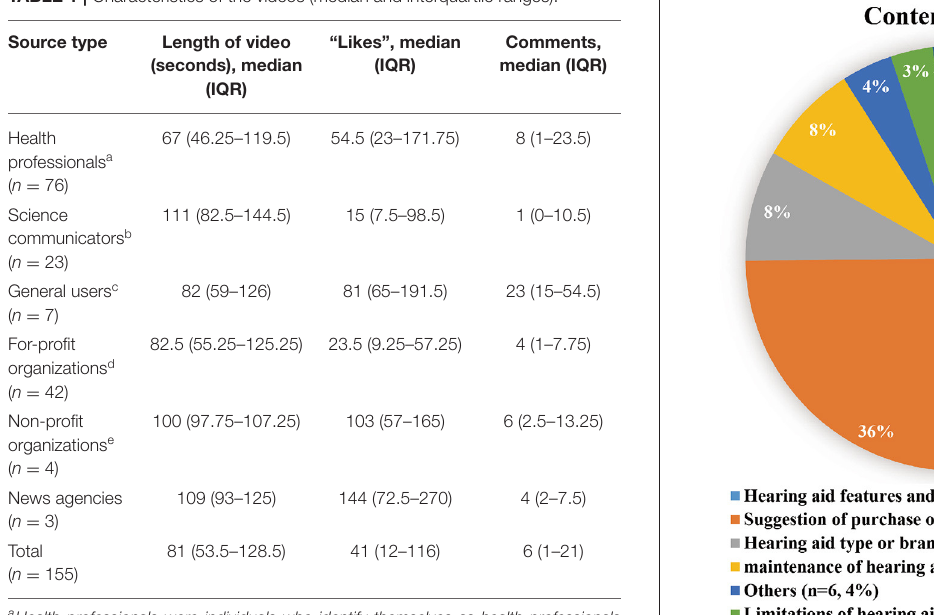
TABLE 1 | Characteristics of the videos (median and interquartile ranges).